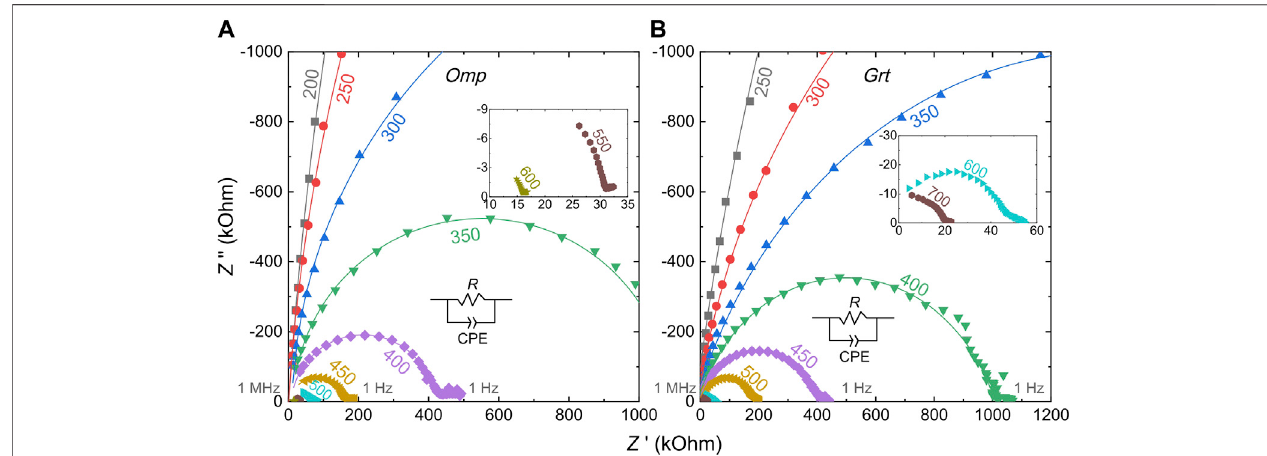
FIGURE 2 | Representative impedance spectra of (A) omphacite (A257) and (B) garnet (A275). Z ′ and Z ″ are the real and imaginary parts, respectively. An equivalent circuit of a single R -CPE circuit element, a resistor R , and a constant phase element (CPE) in parallel was used to fi t the high- frequency arc in each spectrum. The number close to each spectrum is the temperature ( ° C), and insets show spectra at high temperatures. Omp , omphacite; Grt , garnet.